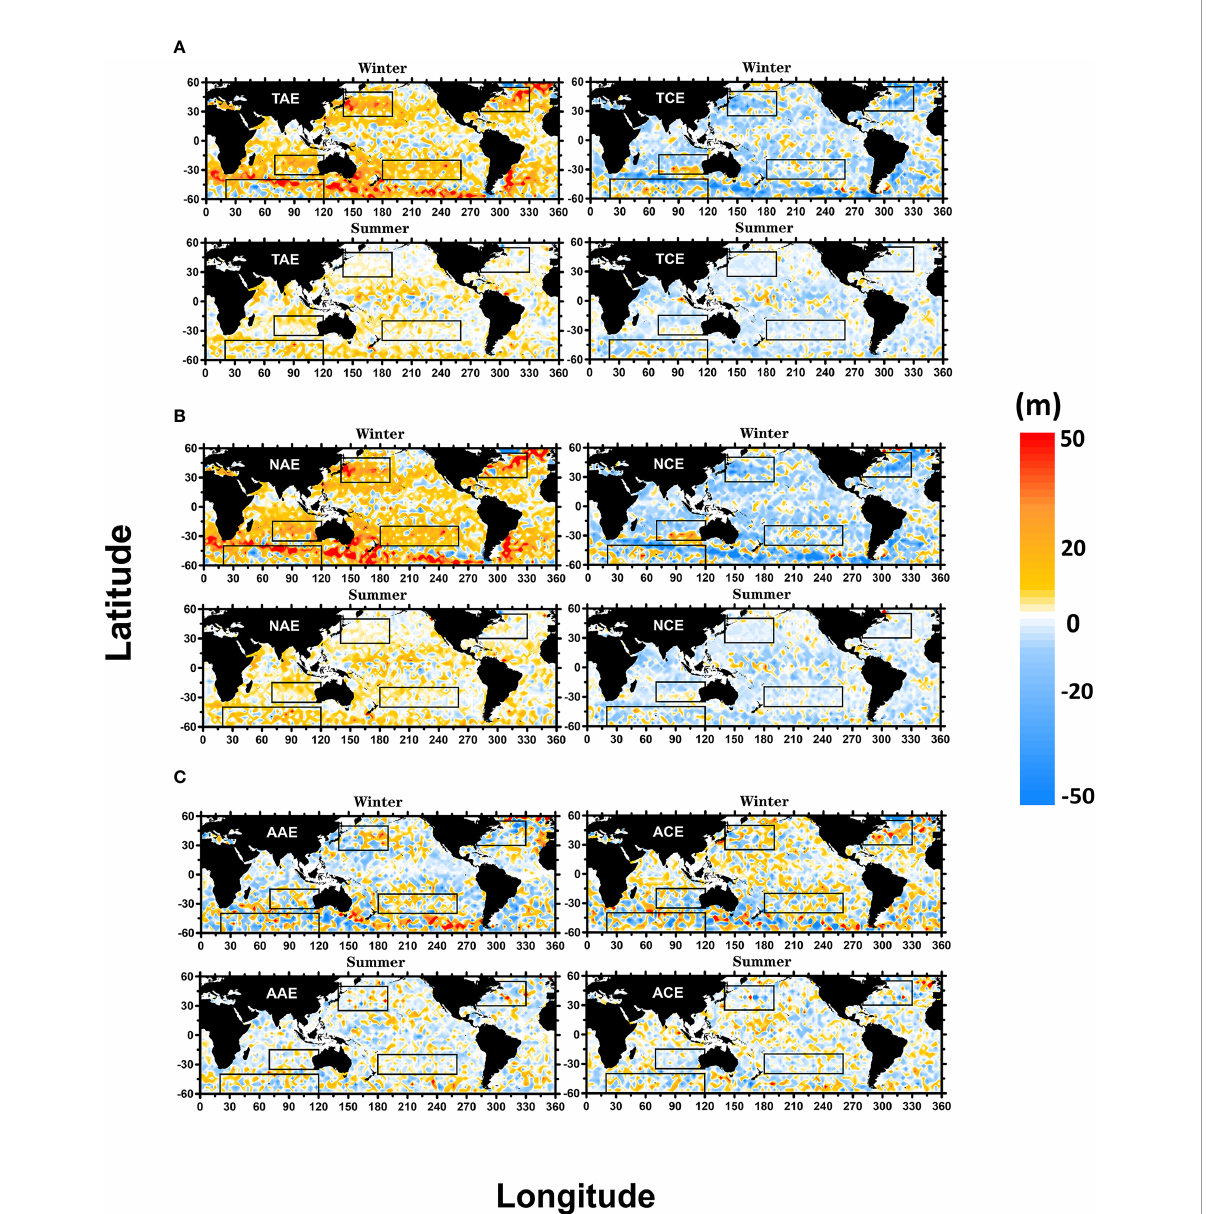
FIGURE 5 Eddy-induced MLD anomalies (MLD anomalies) mapped to a global 3° × 3° grid between 60°N and 60°S. (A – C) represent total, normal and abnormal eddies, respectively. The black box area represents fi ve areas: NA, NP, SP, SIO, and SO. The upper and lower panels are MLD anomalies inside the eddy in winter (Northern hemisphere: December, January, February; Southern hemisphere: June, July, August) and summer (Northern hemisphere: June, July, August; Southern hemisphere: December, January, February) of each hemisphere, respectively. The left and right panels of each submap are TAE, NAE, AAE and TCE, NCE, ACE,